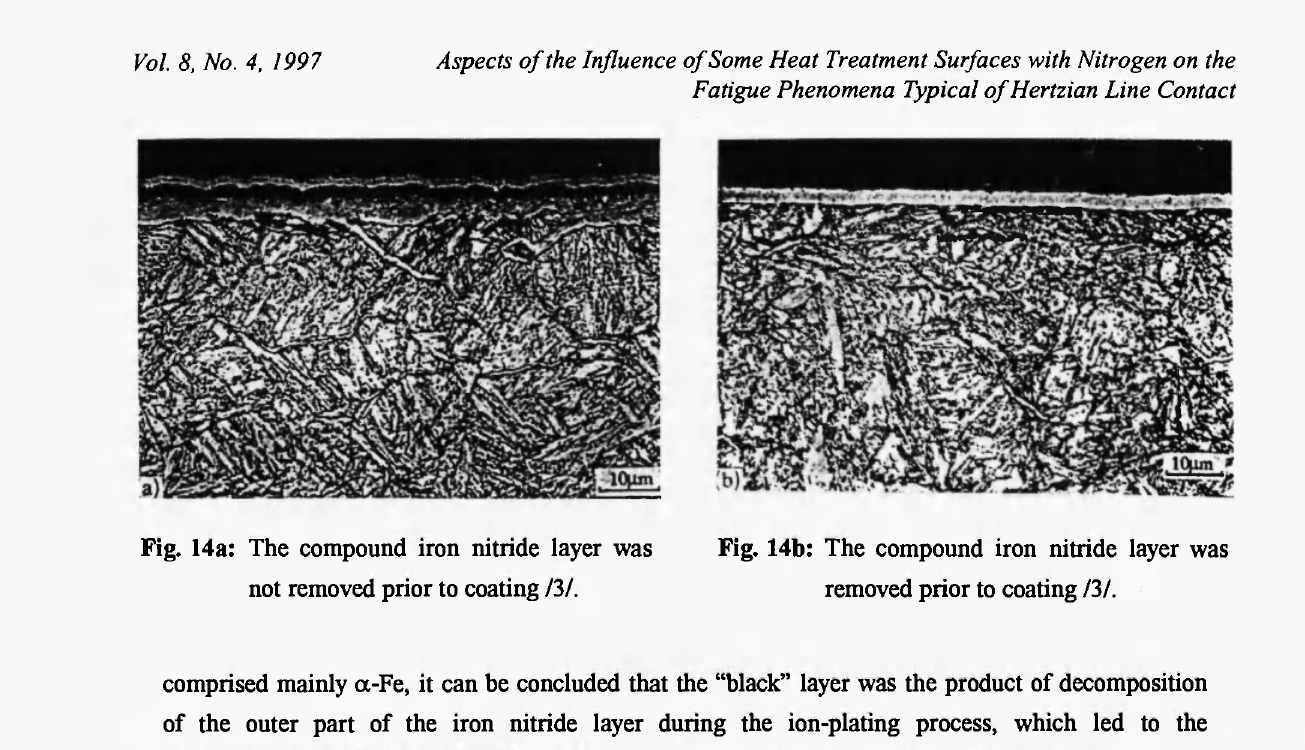
Fig. 14a: The compound iron nitride layer was Fig. 14b: The compound iron nitride layer was not removed prior to coating /3/. removed prior to coating